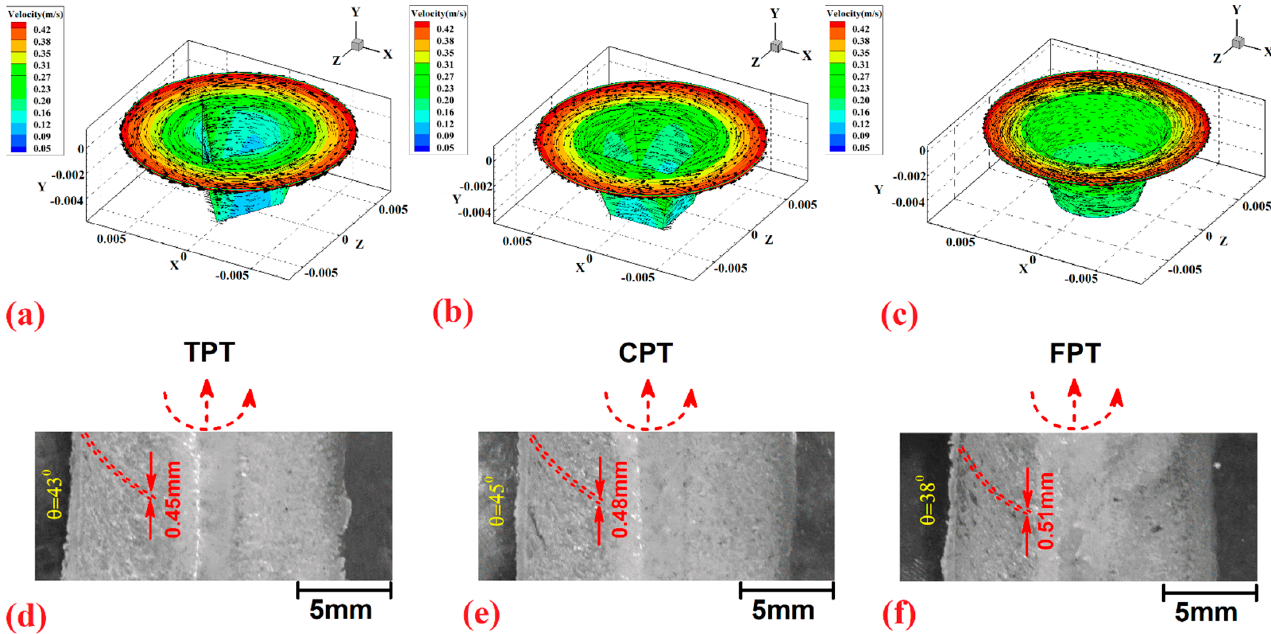
Figure 11. Material velocity inside the stirring zone for joints FSWed by ( a ) TPT, ( b ) CPT, and ( c ) FPT pins. Surface flow of joints FSWed by ( d ) TPT, ( e ) CPT, and ( f ) FPT pins. pins. Surface flow of joints FSWed by ( d ) TPT, ( e ) CPT, and ( f ) FPT